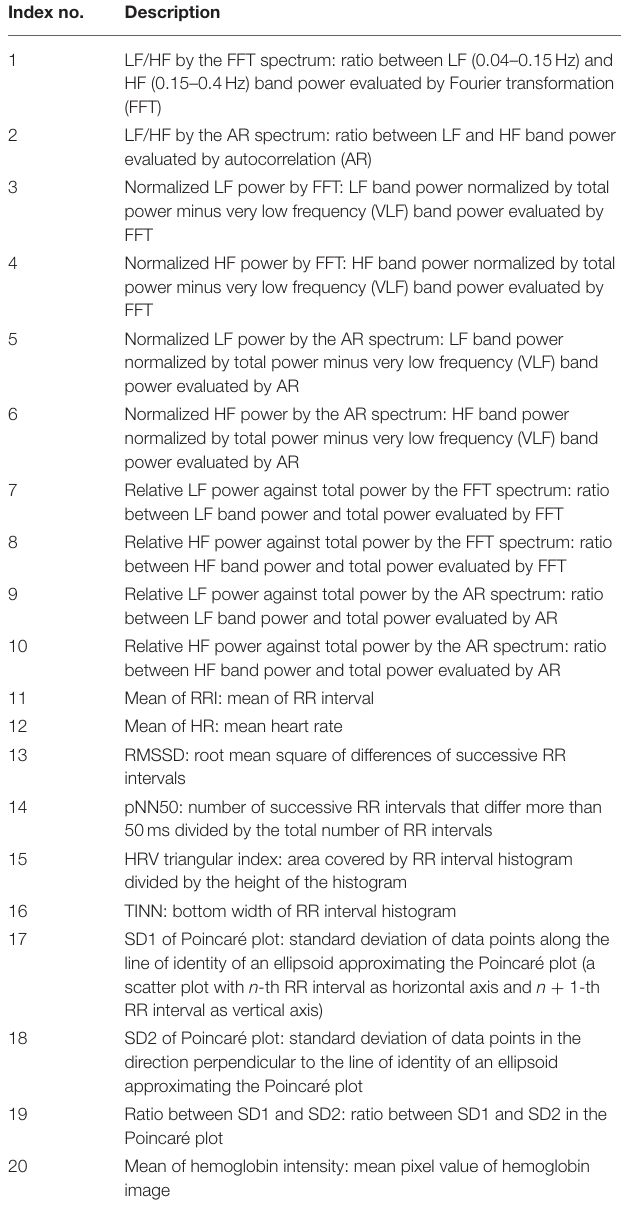
TABLE 2 | Summary of extracted ANS activation indices. Index